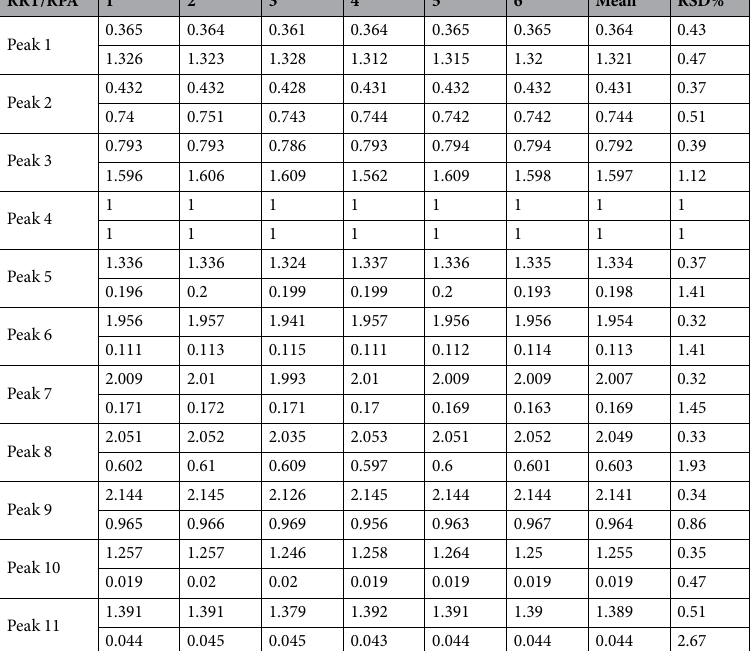
Table 1. Precision test of HPLC